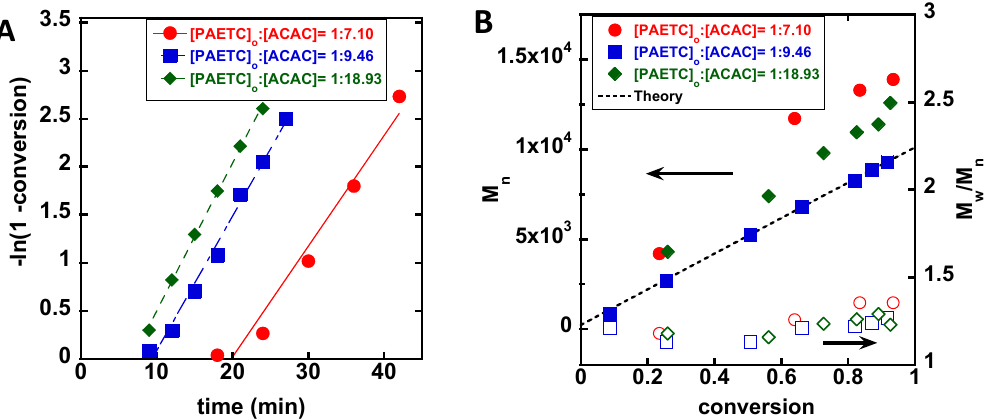
Figure 4. ( A ) Semilogarithmic plots and ( B ) evolution of M n (solid point) and M w /M n (open points) of HRP-catalyzed polymerization. Red points (circles) show [PAETC] 0 :[ACAC] = 1:7.10. Blue points (squares) show [PAETC] 0 :[ACAC] = 1:9.46. Green points (diamonds) show [PAETC] 0 :[ACAC] = 1:18.93. Component ratios utilized were [DMAm] 0 :[PAETC] 0 :[ACAC] 0 :[H 2 O 2 ] 0 = 100:1: X :1.7, and concentrations were [DMAm] = 170 mM, [HRP] = 0.71 mg/mL in 4.2 mL of pH = 5.5, 20 mM acetate buffer at 25 °C.